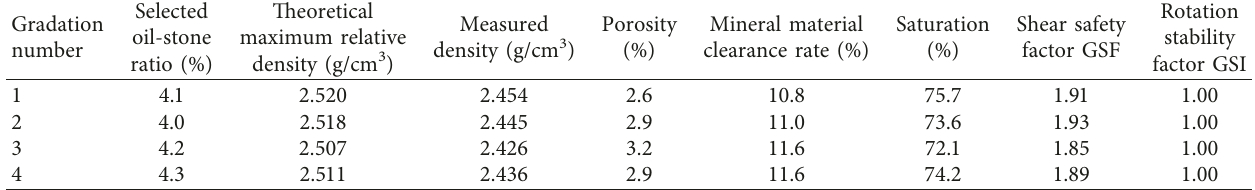
Table 6: Summary table of the optimal oil-stone ratio for selected asphalt mixtures according to the GTM method.